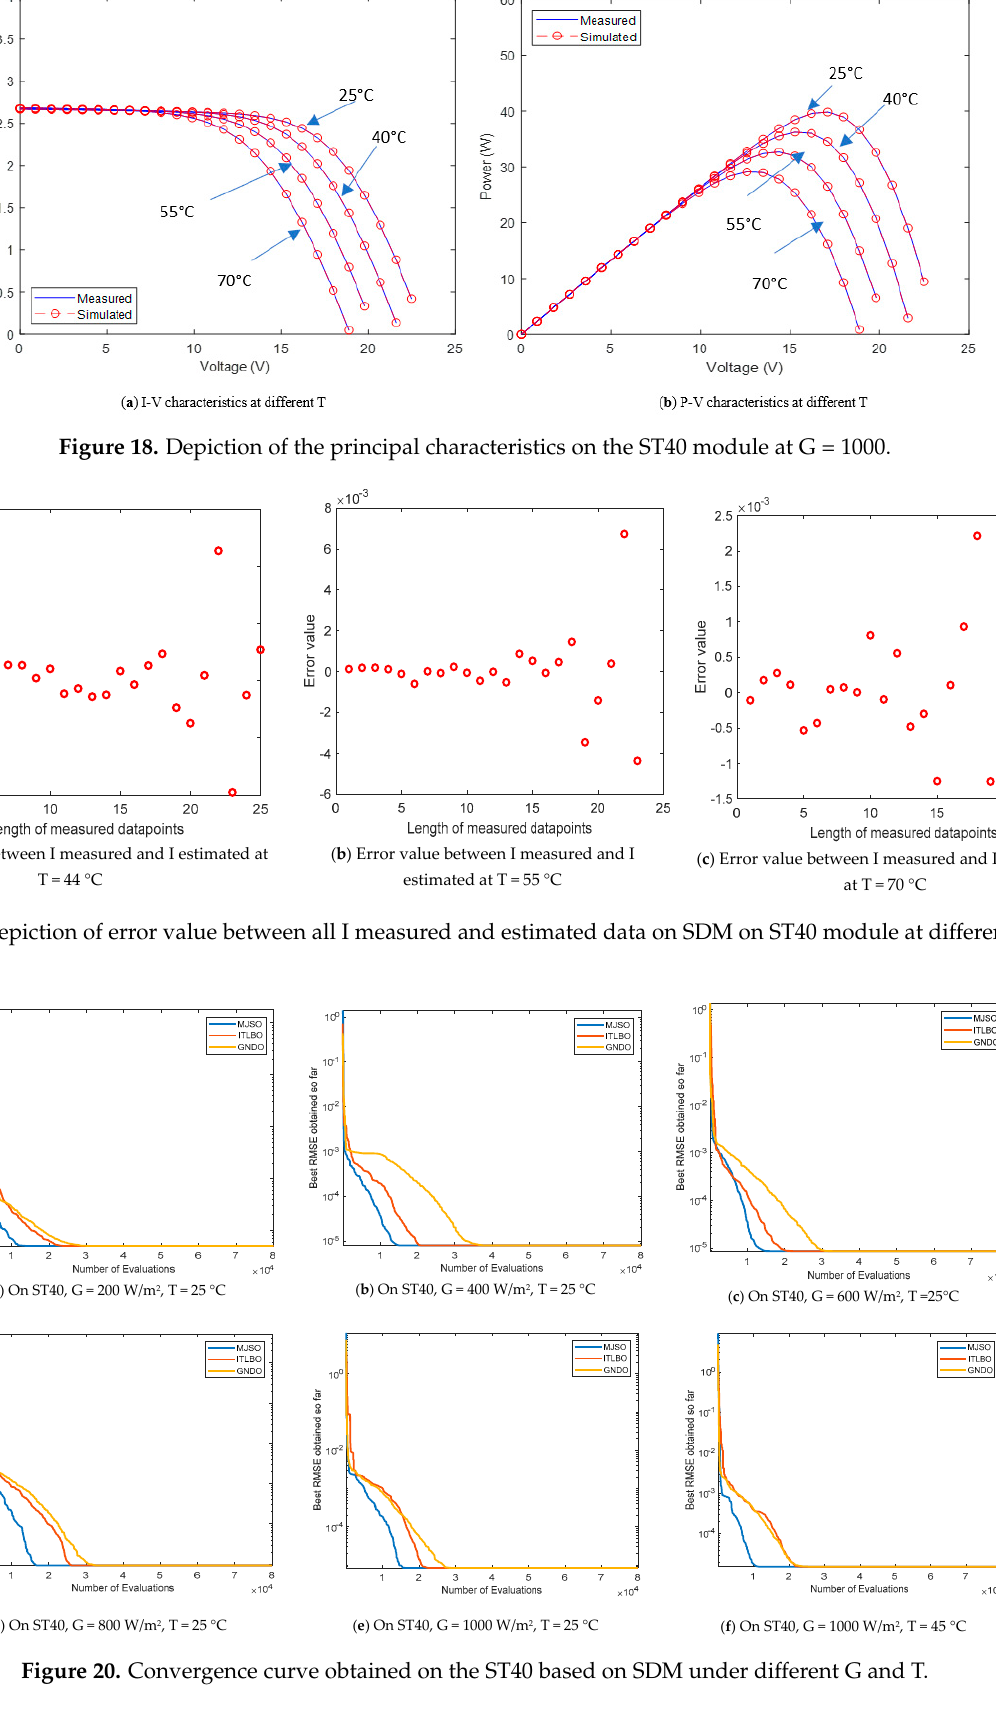
Figure 17. Depiction of error value between all I measured and estimated data on SDM for the ST40 module at different irradiance.